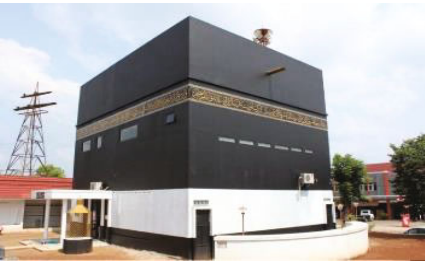
Figure 13: Masjid Ka ’ ba Subang, Indonesia